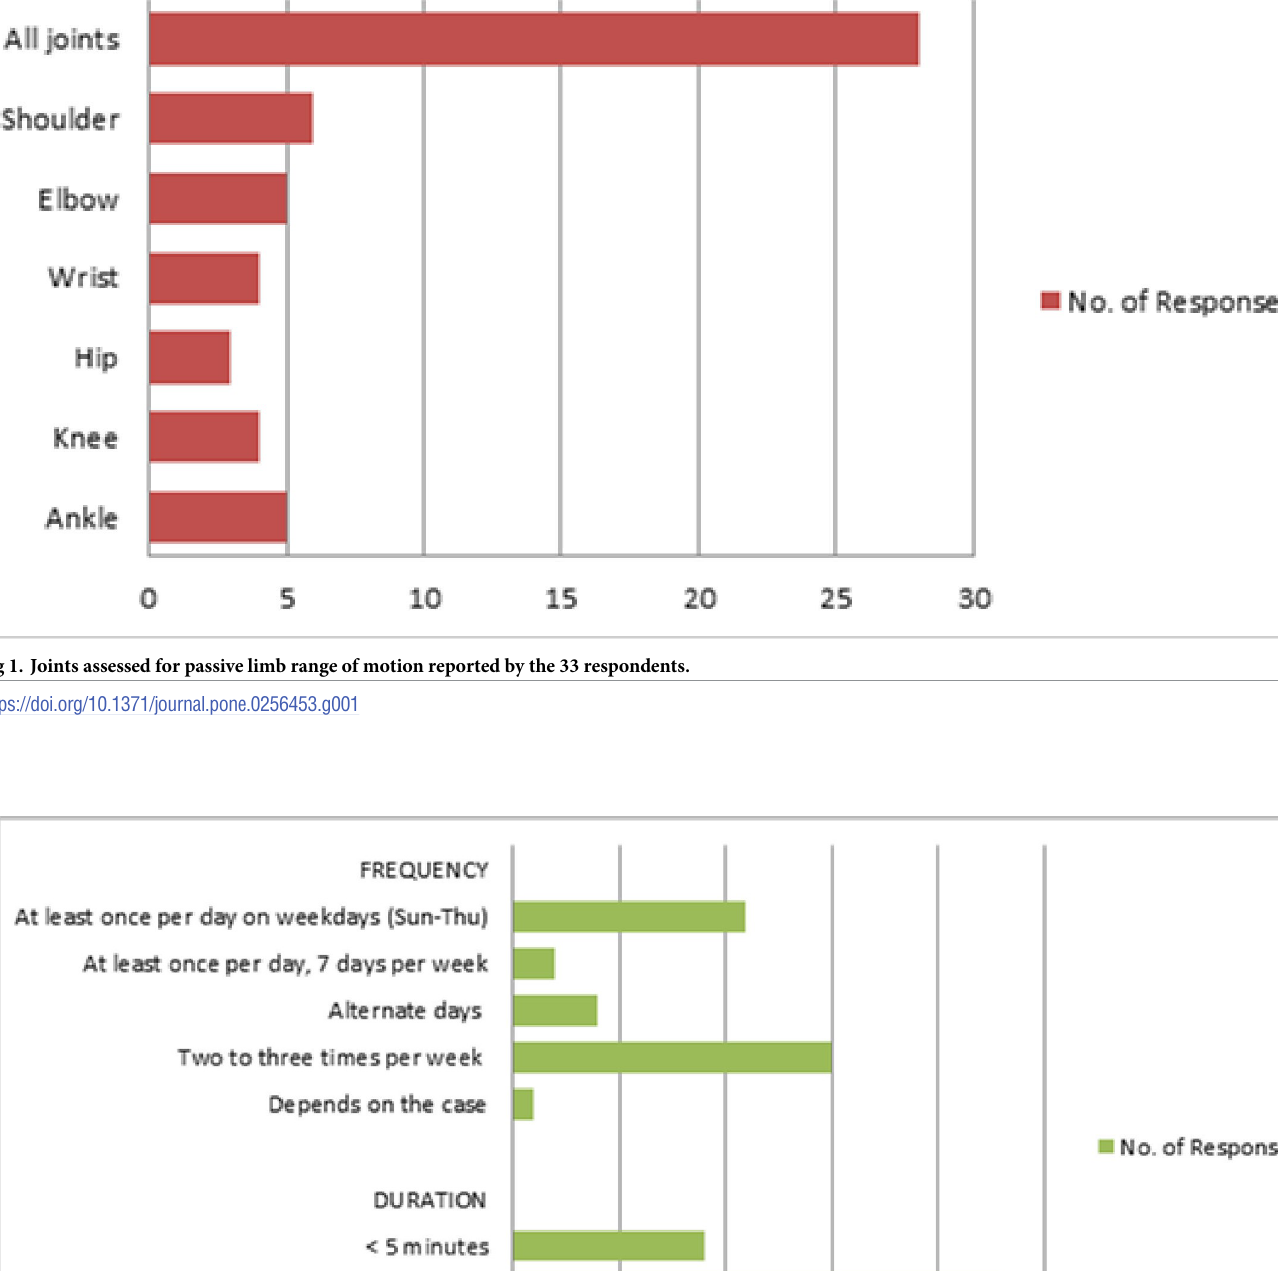
PLOS ONE | https://doi.org/10.1371/journal.pone.0256453 August 20,